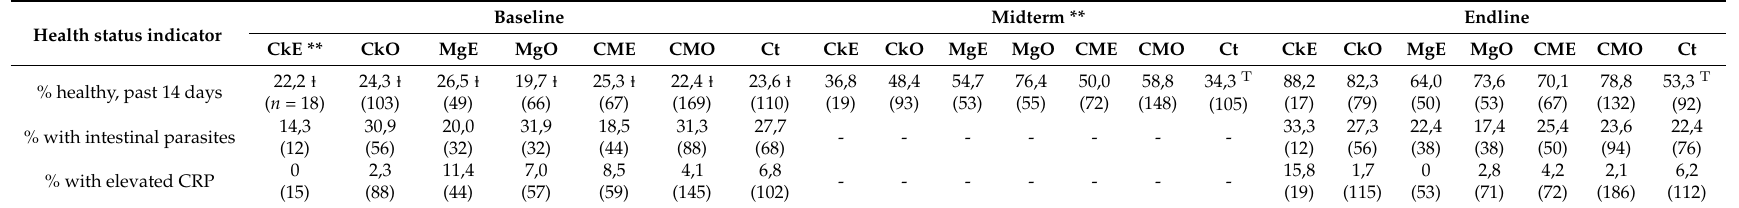
Table 5. Health status among sub-groups of children at baseline, midterm and endline.